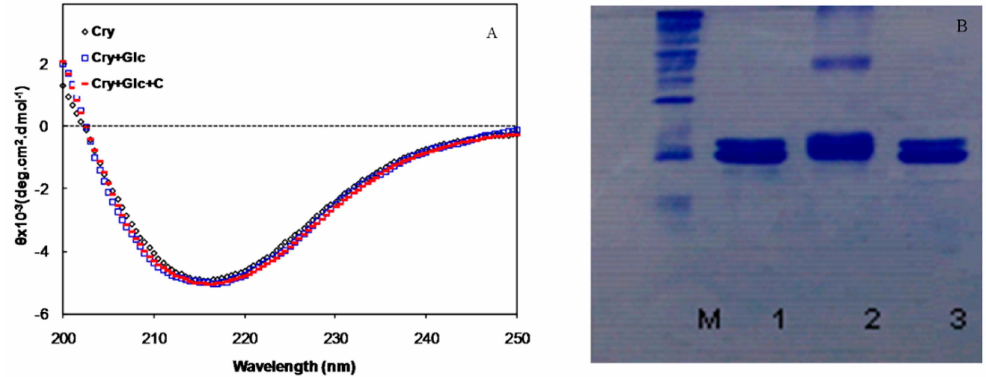
Figure 3. ( A ) Far-UV CD spectra of α -crystallin, in the presence of 500 mM of glucose with and without crocin(s); ( B ) Electrophoretic mobility of α -crystallin. M, Molecular Marker, 1-3, α -crystallin alone, in the presence of glucose and glucose+crocin(s),